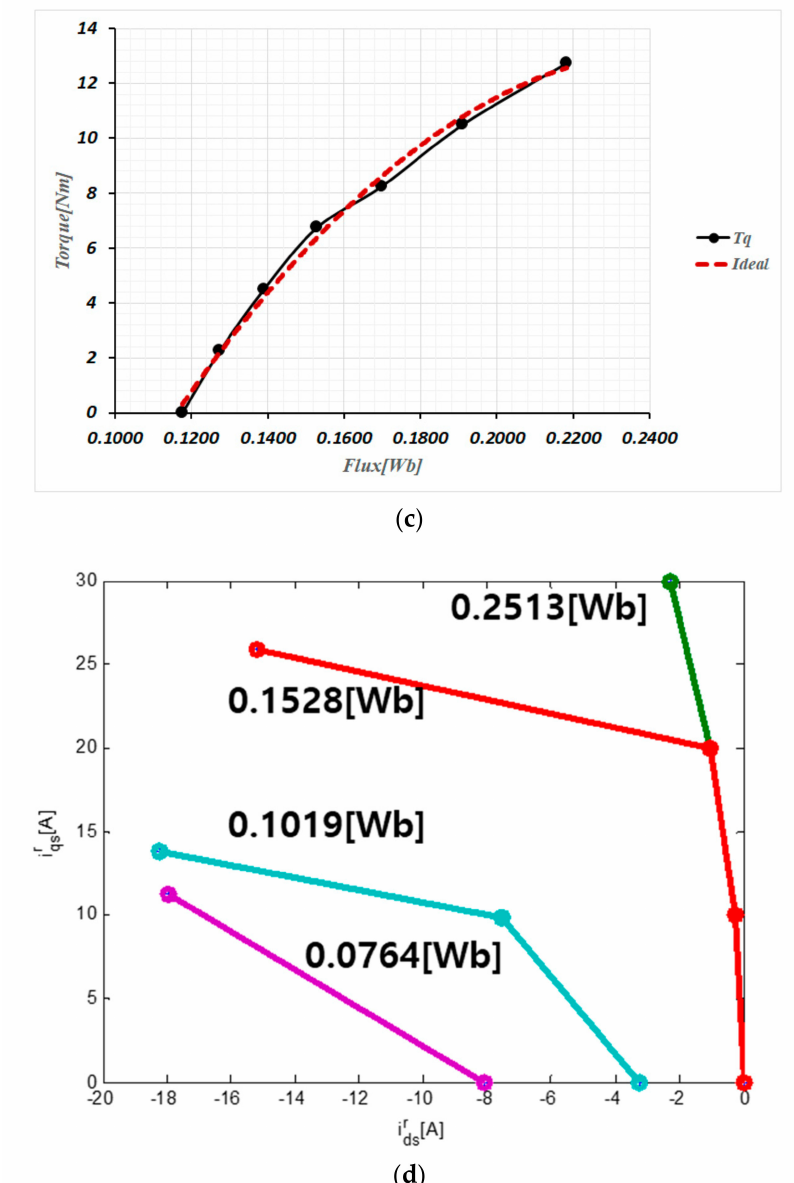
Figure 8. Current maps in the experiment: ( a ) D-axis current map, ( b ) q-axis current map, ( c ) look-up table for the field weakening operation start point, ( d ) d-q-axis current maps according to variable